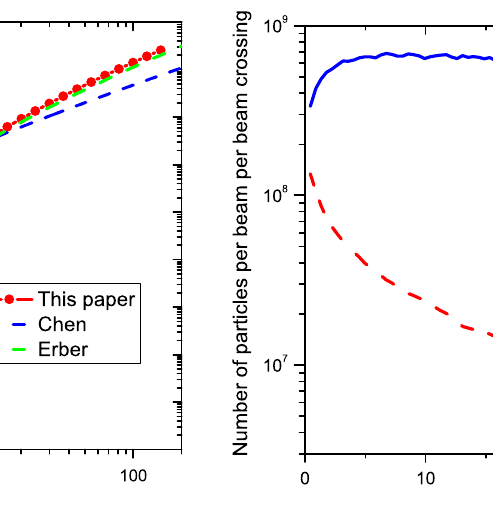
FIG. 10. Bunch length dependence of the yield of the coherent pair production mechanisms. The bunch charge is kept